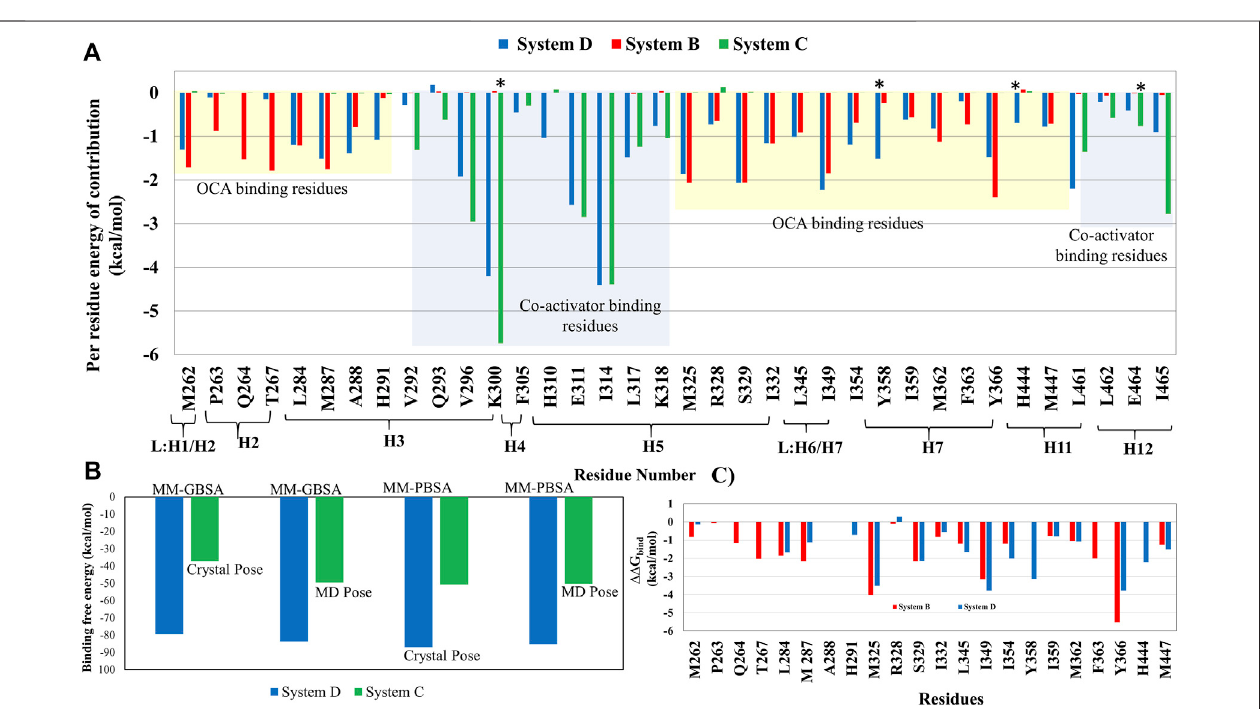
FIGURE 9 | Per residue wise decomposition of the binding energy Δ G bind (kcal/mol) for ‘ OCA ’ and ‘ co-activator ’ . (A) The residues (cut off > 0.5) belonging to the region in FXR are mentioned in the fi gure. The highlighted residues in yellow and blue color are interacting residues with the ‘ OCA ’ and ‘ co-activator ’ , respectively. The residues Y358, H444, K300 and E464 in the star sign are the residues involved in “ activation trigger zone ” and “ charge clamp ” . The residues in System C are different in residue number. However, the location of the residues is the same. The residues number in Systems D/C are V292/299, Q293/300, V296/306, K300/307, F305/ 312,H311/317,I317/321,K318/325,L461/468,L462/469,E464/471andI465/472. (B) ThetotalenergychangeintheresidueafteralaninescanninginbothSystemB and D. (C) The bar plot represents the total binding free energies of crystal poses and MD-pose in both Systems C and